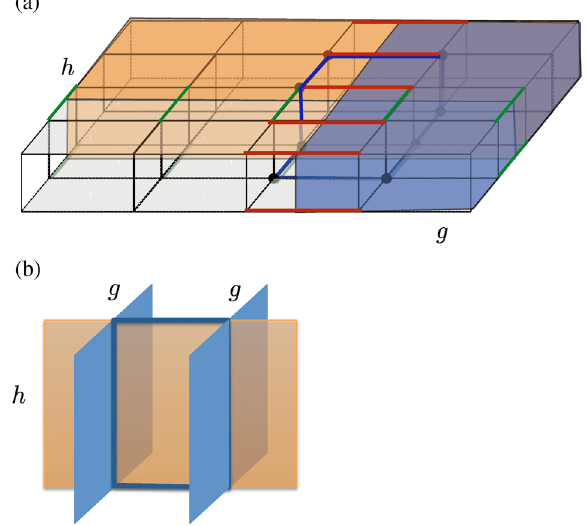
FIG. 12. Intersecting pairs of domain walls. (a) Here, we first act with g on all spins inside the blue-shaded region, twisting all singlet chains along the set of red edges by g . We next act with h on all spins inside the mauve-shaded region. This will twist the singlet chains on a second set of bonds (shown in green) by h , and also generate a phase factor of ð − 1 Þ n s for each red edge inside the mauve region. (b) When acting on states where B equivalent to running a semion string (thick blue line) around the